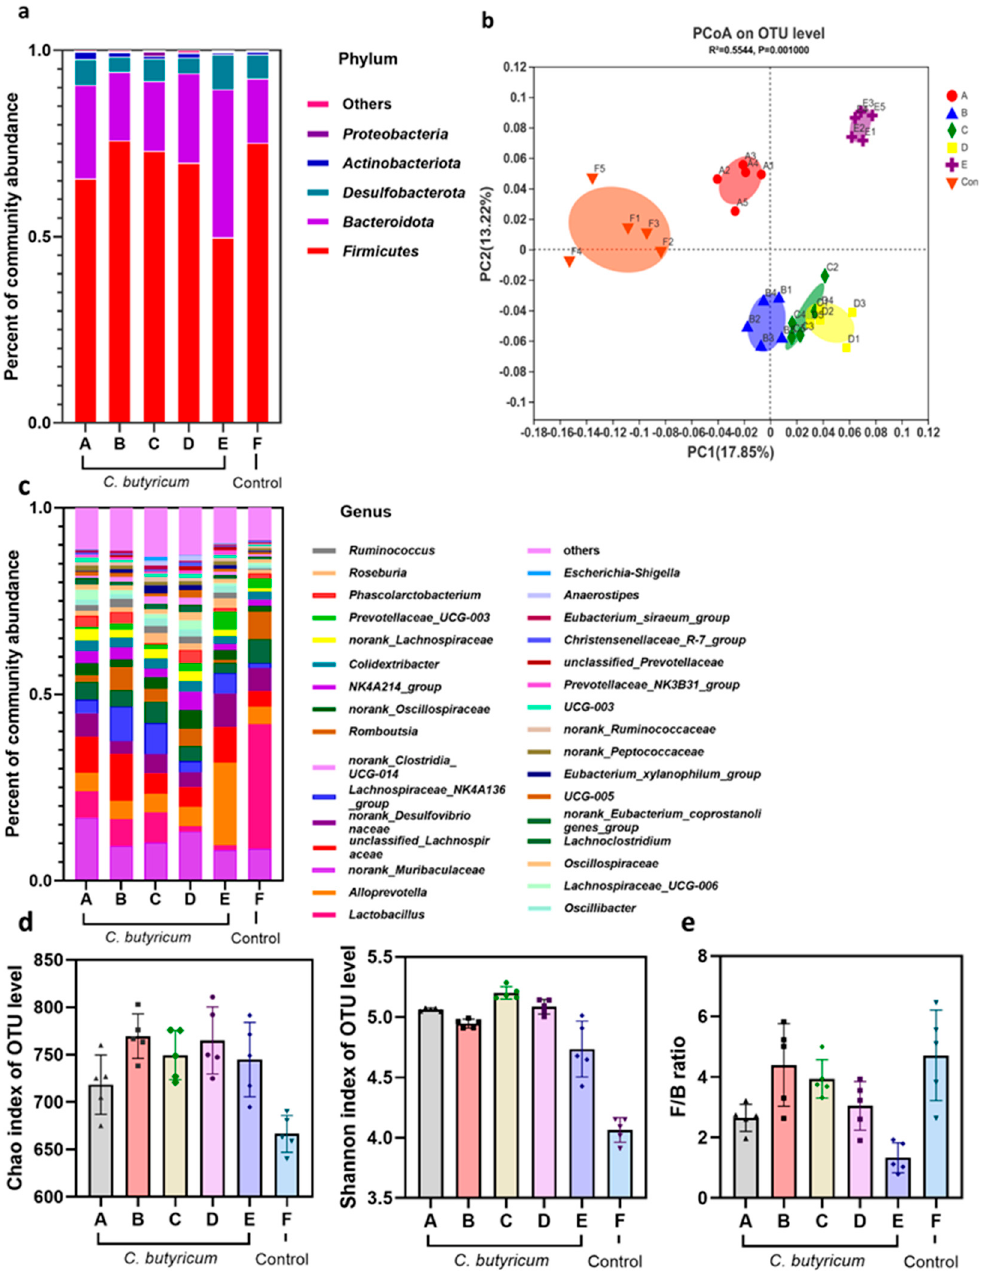
Figure 3. C. butyricum alters the intestinal flora of Wistar rats. Community abundance percentage plots showing the bacterial phyla and genera most differing in abundance between the treatment groups. ( a , c ) The colors of community abundance percentage plots represent the relative percentage of microbial families assigned to each sample. ( b ) Beta diversity of gut microbes analyzed by PCoA. PCoA used unweighted unifrac analysis to calculate the distances between the 6 groups in the colonic stool samples. The percentage shown on each axis explains the proportion of each dimension. ( d ) 16S rDNA V3-V4 sequencing to evaluate Chao richness and Shannon diversity. ( e ) The Firmicutes / Bacteroidetes ratio was calculated as a biomarker of intestinal flora dysbiosis. A: day 6th after administration; B: day 4th after administration; C: day 2nd after administration; D: 24 h after administration; E: 12 h after administration; F: administration of sterile saline group (control).